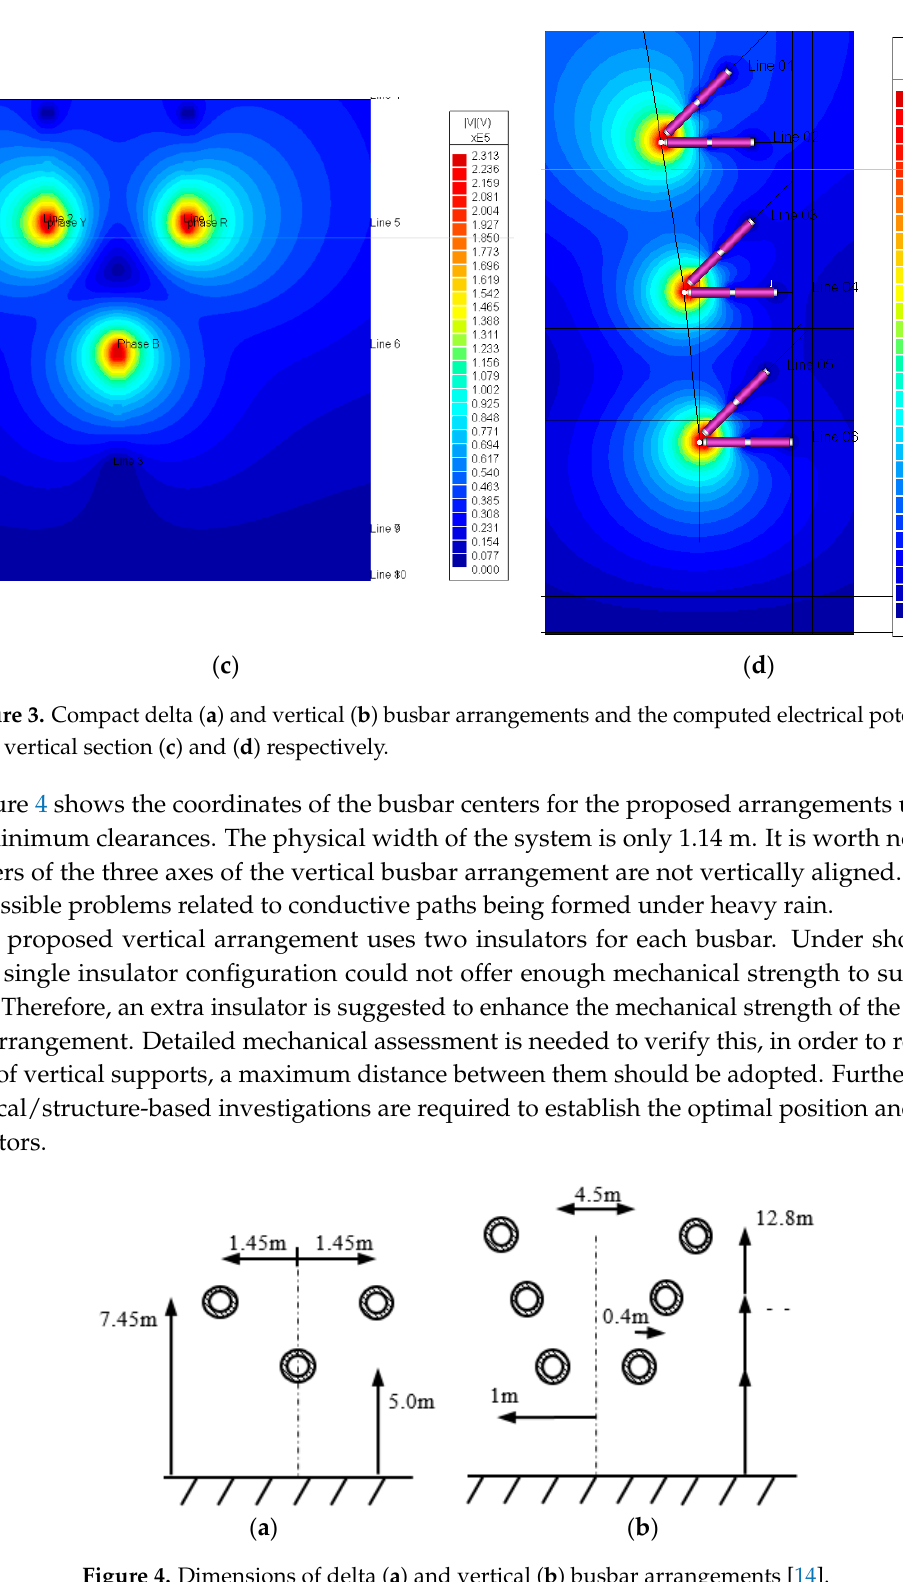
Figure 4. Dimensions of delta ( a ) and vertical ( b ) busbar arrangements [14].